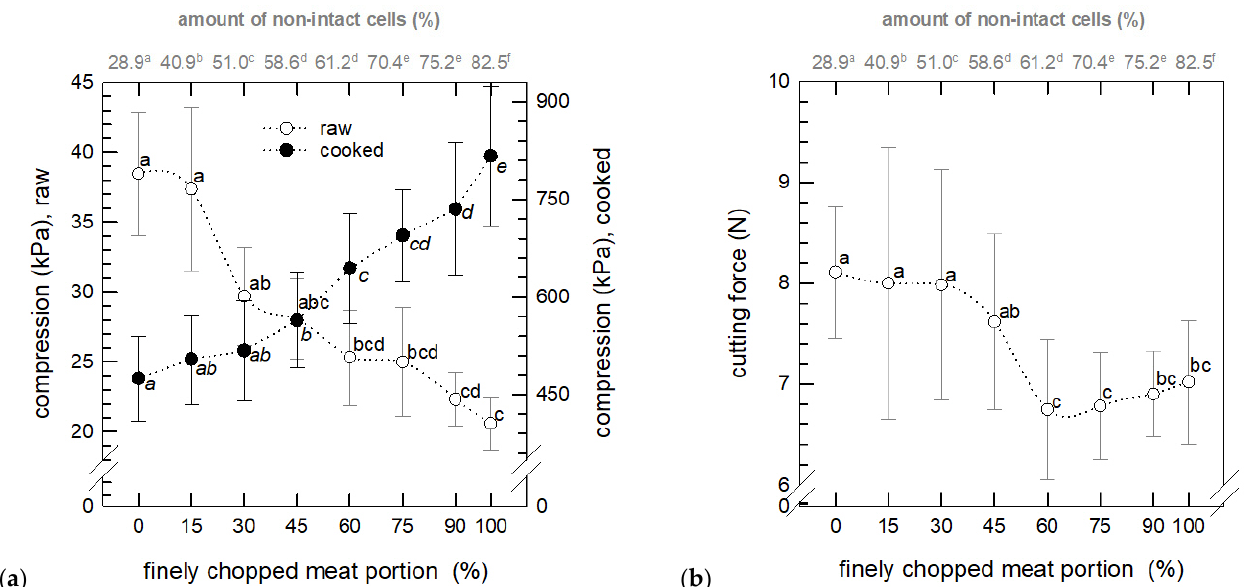
Figure 5. Mean ± standard deviation of ( a ) compression of raw (white) ( n = 12) and cooked (black) ( n = 27) minced meat with finely chopped meat added and ( b ) cutting force of cooked minced meatballs ( n = 30). For comparability, amount of non-intact cells is illustrated on top of graph. Different letters indicate significant differences ( p < 0.05) for each parameter (cooked in italic).